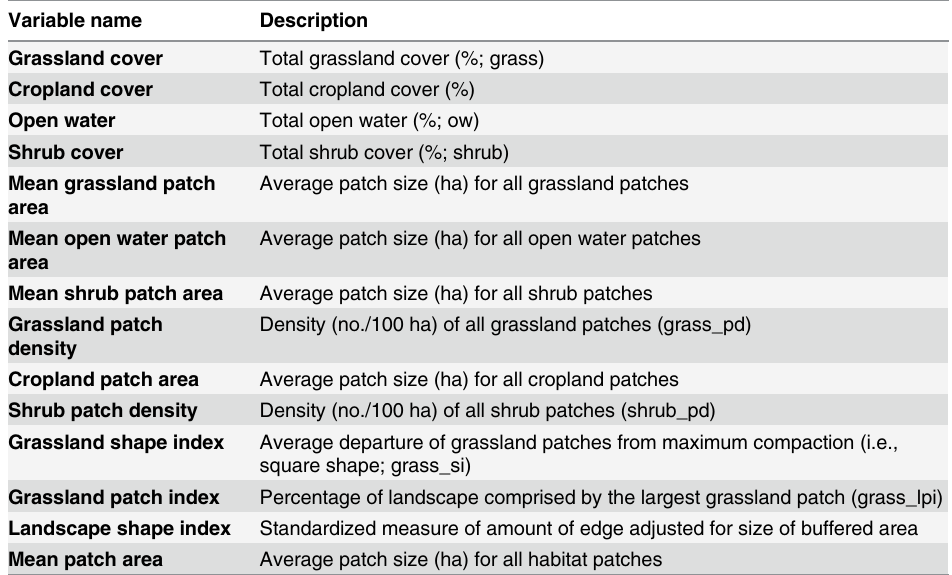
Table 1. Final variables we quantified within capture areas used for evaluating potential habitat effects on pronghorn neonatal survival in western South Dakota, USA, 2002 –